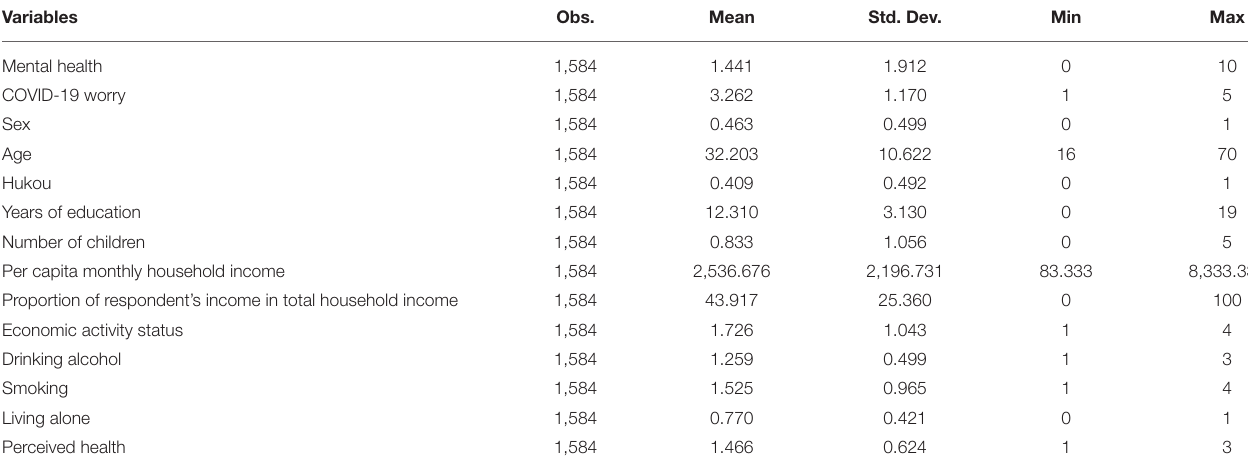
TABLE 1 | Statistics of the variables. Variables Obs. Mean Std.